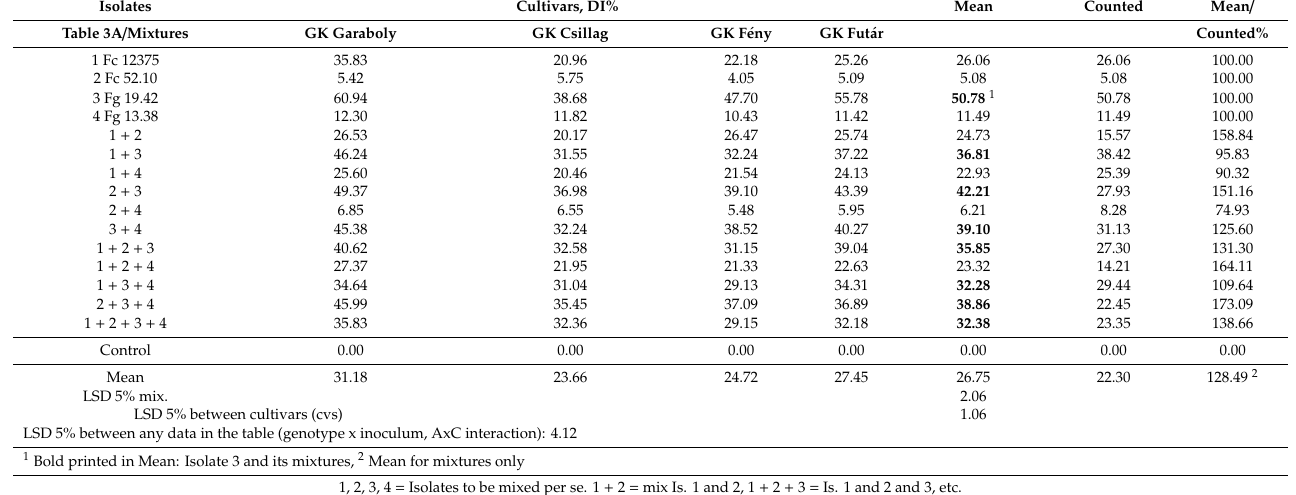
Bold printed in Mean: Isolate 3 and its mixtures, 2 Mean for mixtures only Table 3B / Correlations